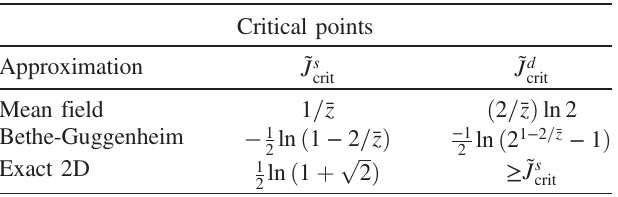
TABLE II. Statical and dynamical critical point as a function of the coordination number ¯ z obtained within the mean field and Bethe-Guggenheim approximation, alongside the exact statical ˜ J s critical point for the two-dimensional Ising model at zero crit ˜ h ¼ 0 . The exact dynamical field and binding affinity, ˜ μ ¼ ˜ J d critical point for the two-dimensional Ising model remains crit unknown; a lower bound is given by the Onsager statical critical